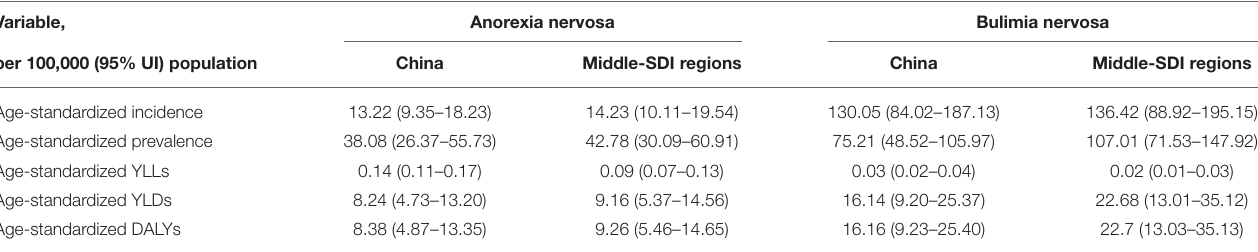
Age-standardized